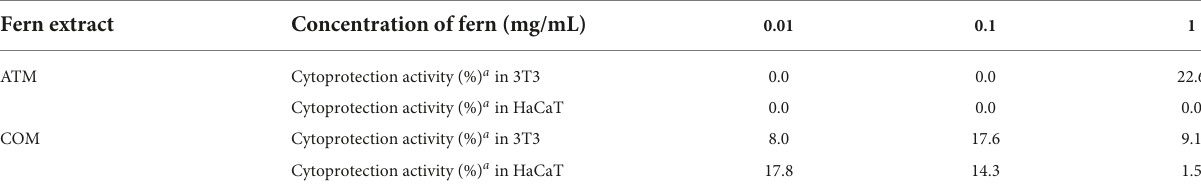
TABLE 2 Cytoprotection activity of ATM and COM in 3T3 and HaCaT cell lines for 2 mM H 2 O 2 during 2.5 h by MTT